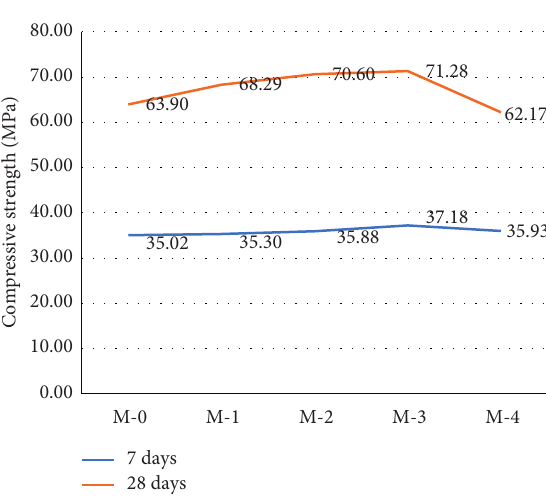
Figure 2: Compressive strength test